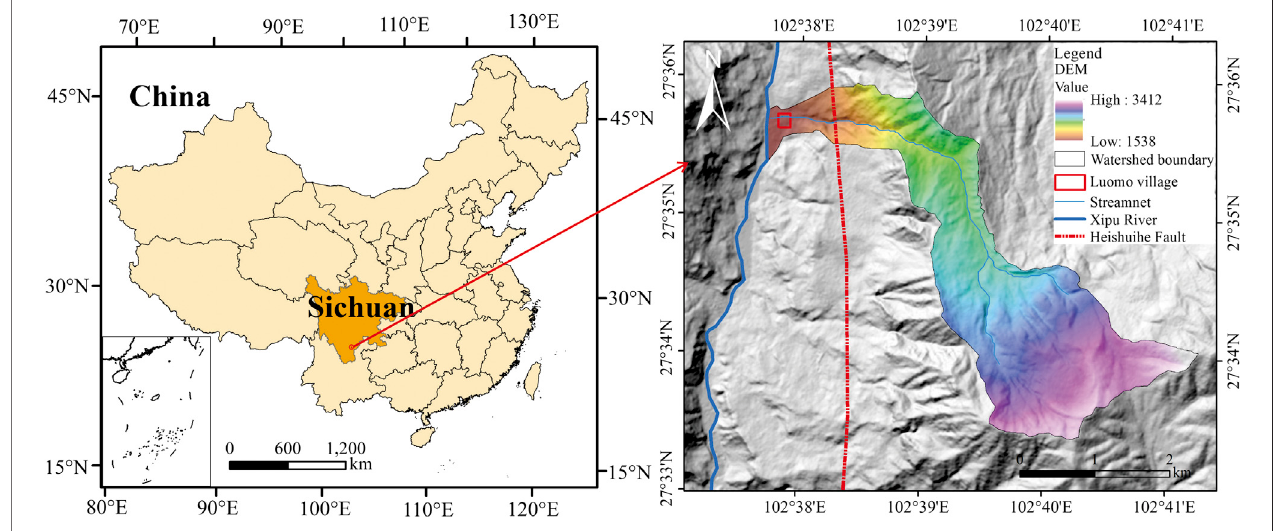
FIGURE 1 | Location and topographical map of Niunaidu